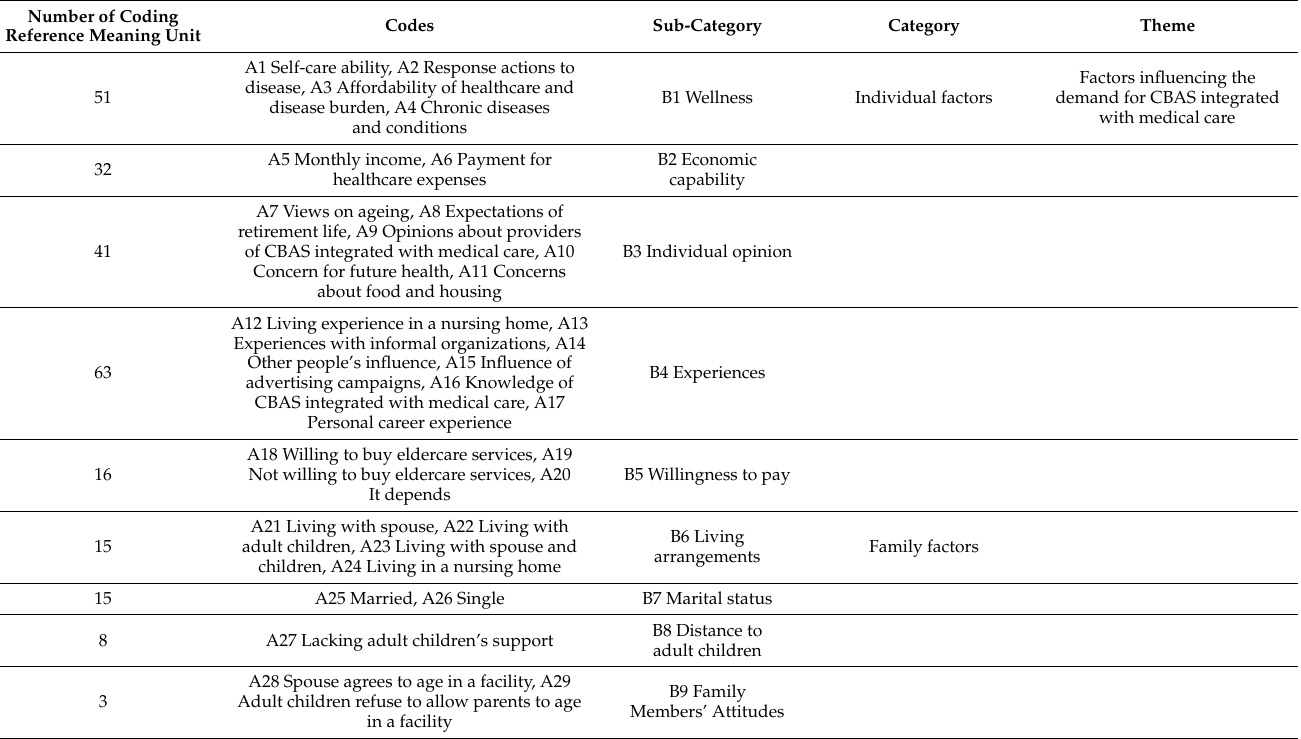
Table 3. Qualitative content analysis